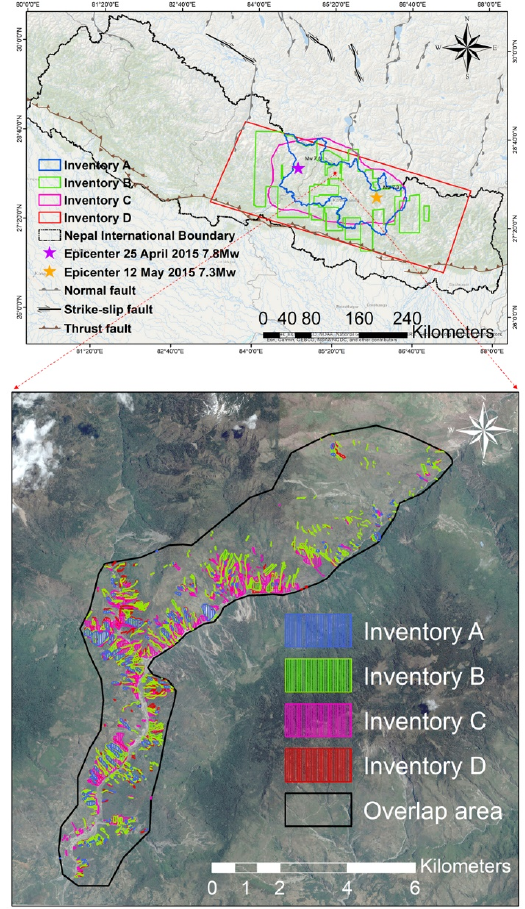
Figure 1. Area covered by the different investigators during mapping landslide inventories of the 2015 Gorkha earthquake.